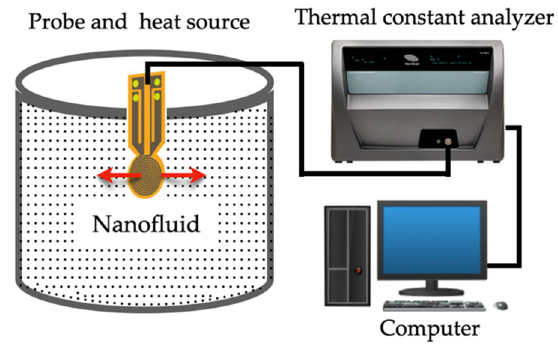
Figure 8. Illustration of the transient plane source (TPS) technique: red arrows represent the direction of the heat flux (adapted from Lin et al. [80]).